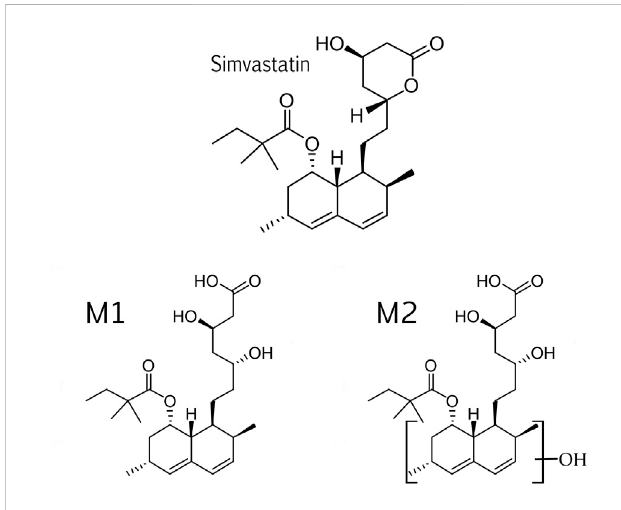
FIGURE 5 Structures of simvastatin and its metabolites, M1 and